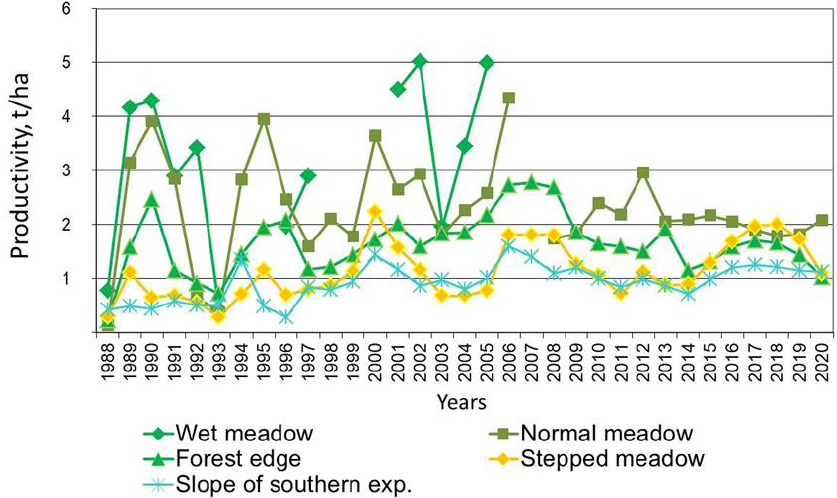
Figure 4. Dynamics of phytocenosis productivity of the model alas.